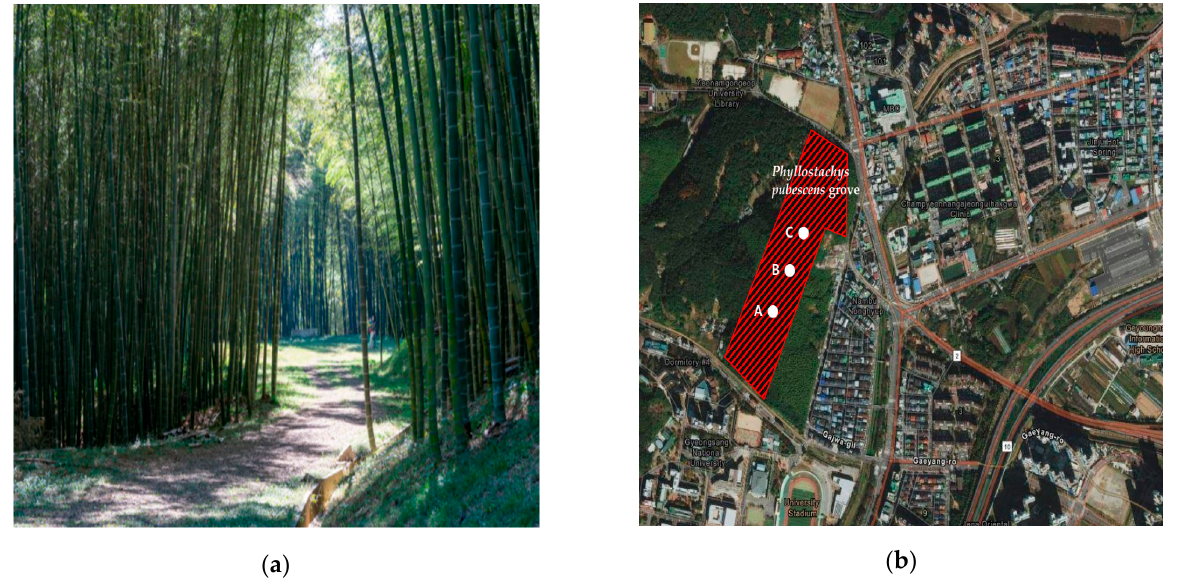
Figure 1. Figures of study sites: ( a ) Gajwa Phyllostachys pubescens grove; ( b ) NVOC measurement points (shaded area is Phyllostachys pubescens groves, and points A, B, and C are shown in the figure).